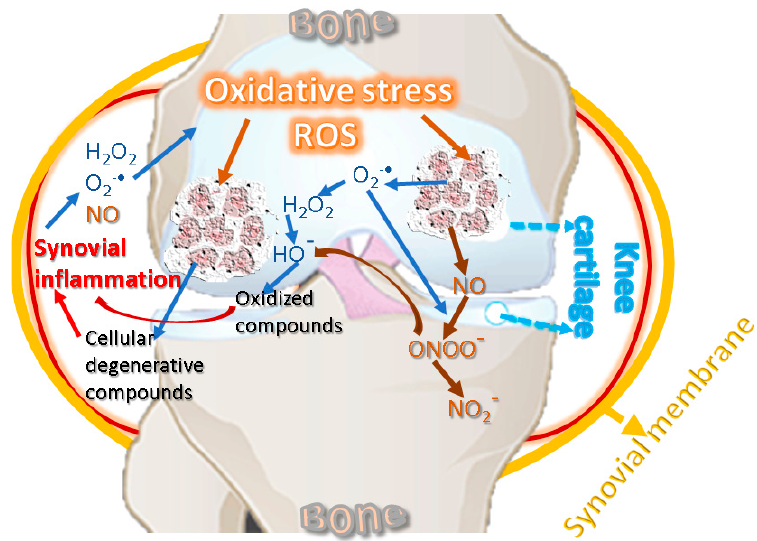
Figure 2. Oxidative stress and inflammation reciprocal cause-and-effect cycle.